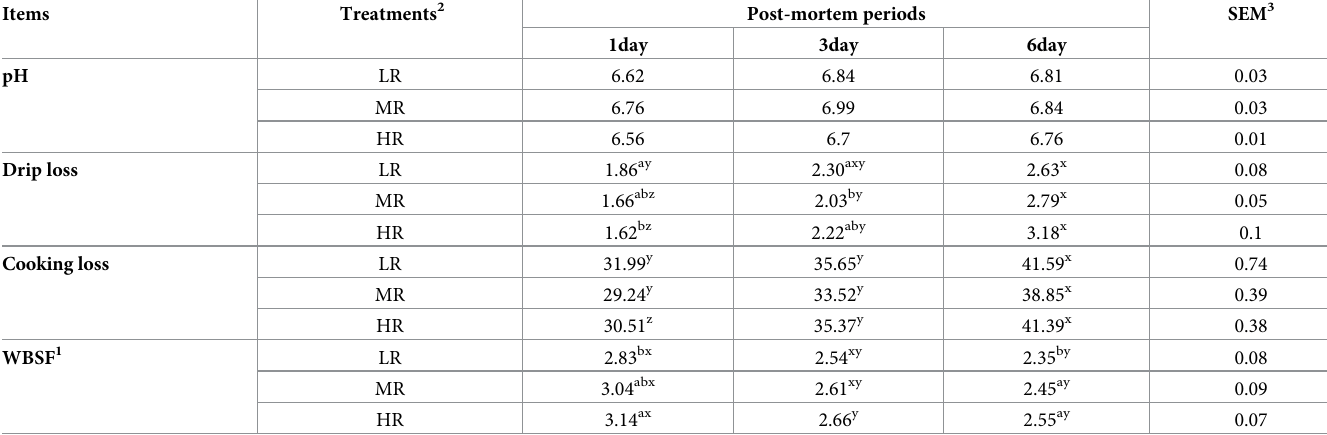
Table 6. Effect of dietary n -6: n -3PUFA ratios on meat pH, drip loss (%), cooking loss (%) and shear force (kg) of Longissimus dorsi in goats.